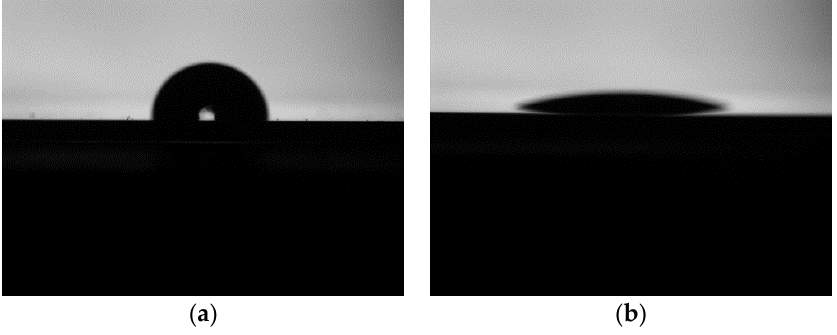
Figure 4. The contact angle of the quartz surface: ( a ) before the quartz surface was activated and ( b ) after the quartz surface was activated.